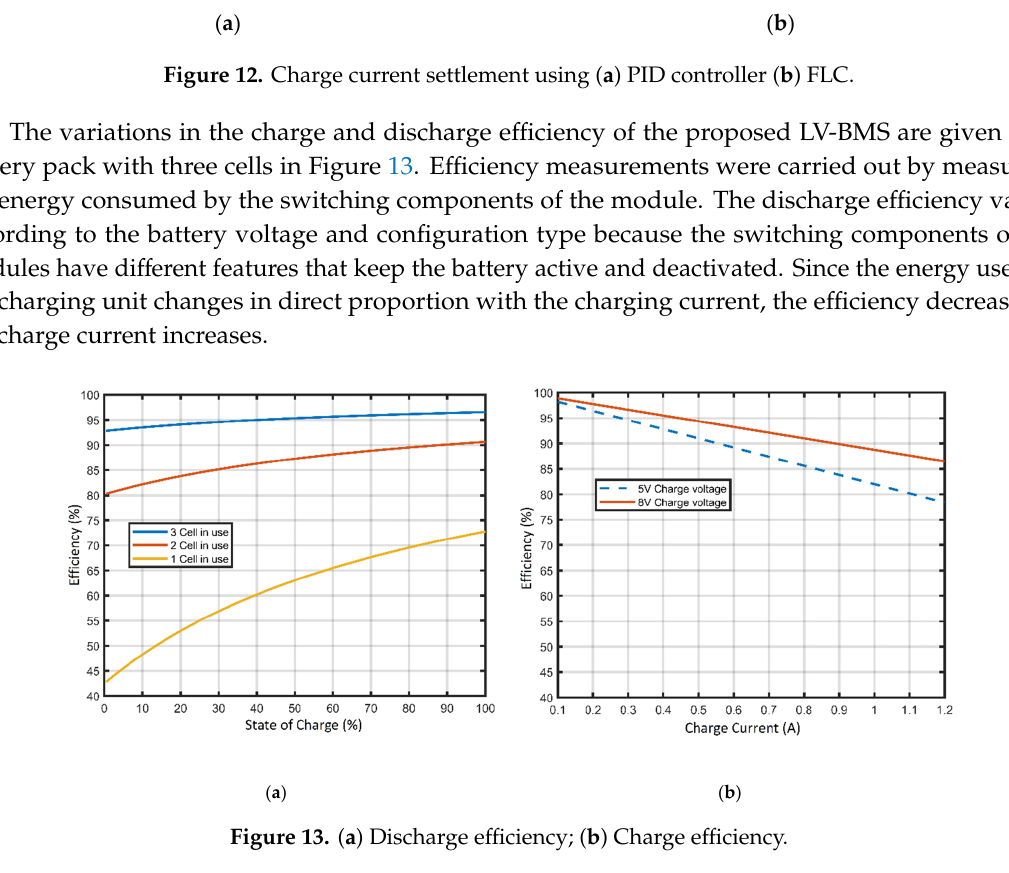
Table 4. Comparison with previous studies.